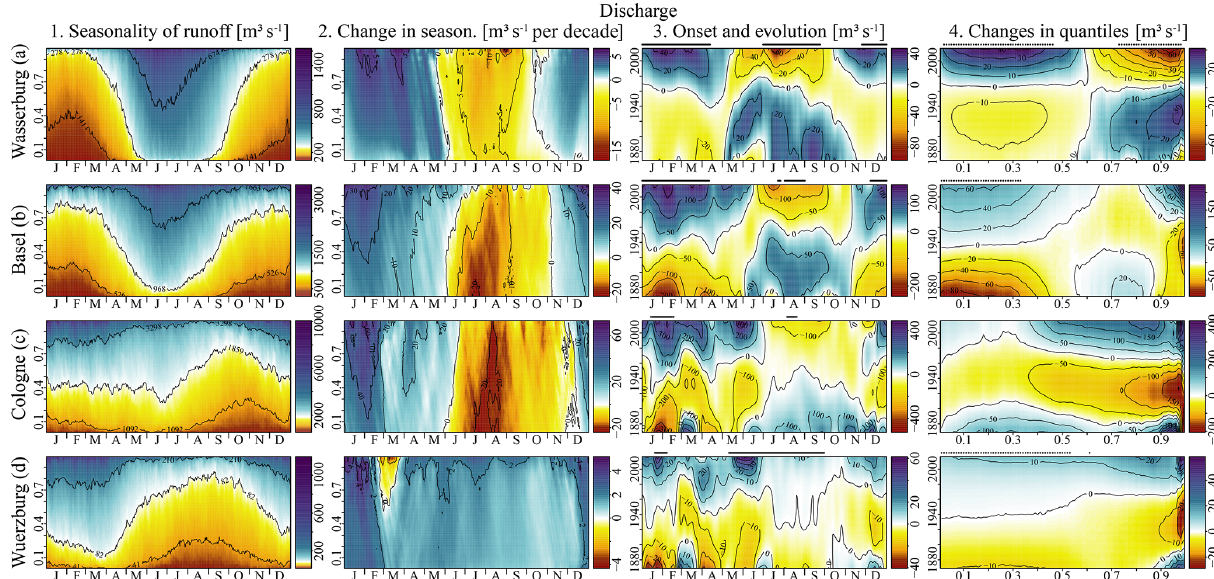
Figure 4. Seasonality of river runoff, change in seasonality, onset and evolution of changes and changes in quantiles for discharge measured at gauges Wasserburg (a) , Basel (b) , Cologne (c) and Würzburg (d) . Isolines in left panels “1. Seasonality of runoff” indicate quantiles for probabilities 0.1, 0.5 and 0.9 determined over the entire time series using all available measurements. Points on top of the panels (two right columns) indicate days/probabilities with significant changes according to the Mann–Kendall trend test. Time frame investigated: